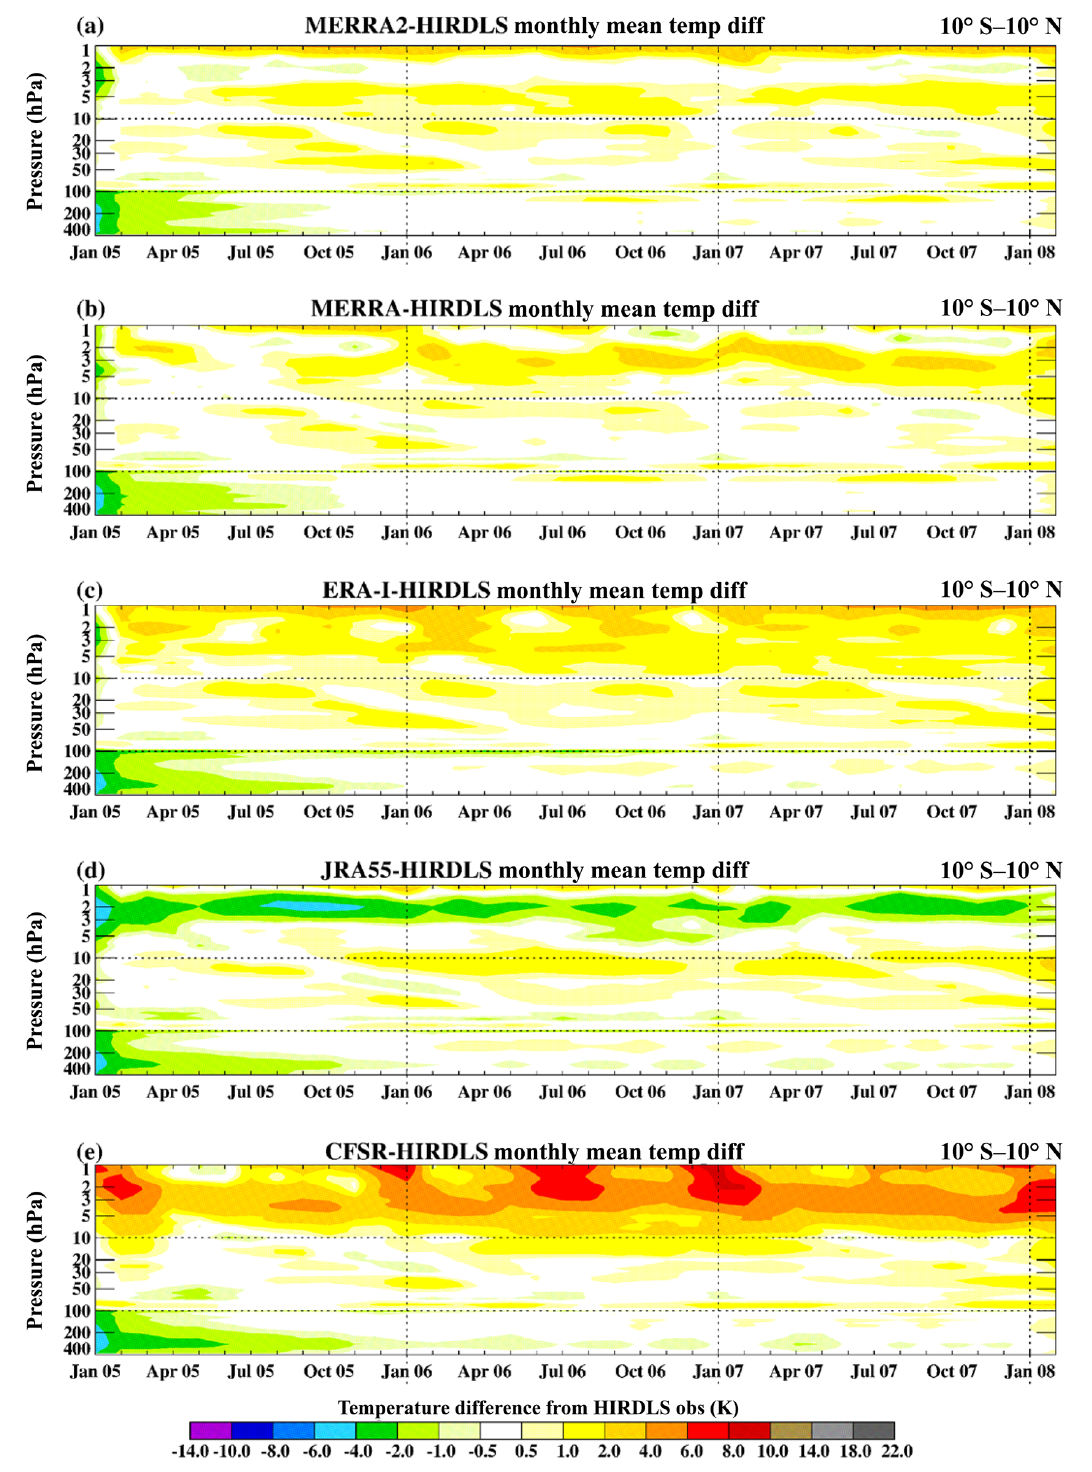
Figure 14. Same as Fig. 12 except for the equatorial-latitude zone (10 ◦ S–10 ◦